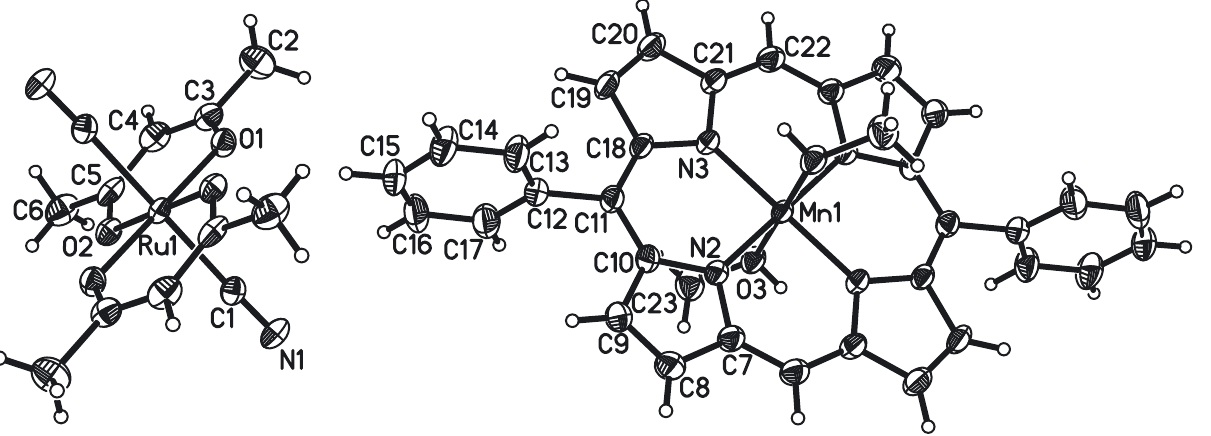
Table  : Data collection and